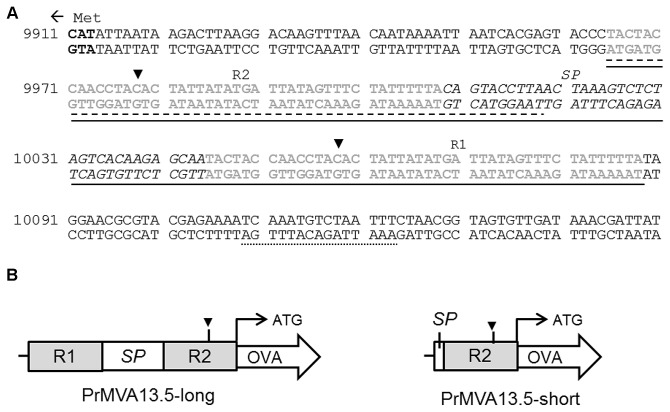
The MVA13.5L promoter.(A) The MVA sequence 250 nucleotides (nt) upstream of the MVA13.5L open reading frame (ORF) with a ‘left’ orientation is shown (GenBank accession number AY603355). The ATG encoding for the methionine (Met) within the MVA13.5L ORF is shown in bold. The arrow indicates the direction of transcription for the MVA13.5L gene. The two transcriptional start sites (TSS) for the MVA13.5L gene are indicated by black arrow heads. TSS1 correspond to nt 9 978 and TSS2 corresponds to nt 10 058 in the MVA genome. The two 44 nt repeats, denoted R1 and R2, are shown as grey sequences. The 36 nt spacer region between R1 and R2, denoted SP, is shown as sequences in italic. The sequences used to construct the PrMVA13.5-long promoter (9 965–10 088 nt) are underlined with a solid line. Sequences used to construct the PrMVA13.5-short promoter (9 965-10 019 nt) are underlined with a dashed line. (B) The features of the native PrMVA13.5-long and PrMVA13.5-short promoter are depicted graphically. The PrMVA13.5-long consists of the two repeated motifs (R1 and R2) shown as grey boxes separated by the spacer region (SP). The PrMVA13.5-short consists of only the R2 motif and 11 nt of the spacer region (SP). The TSS1 is shown as a black arrowhead. The promoters were used to generate an OVA expression cassette introduced into the MVA genome at IGR 44/45. The position of the promoter sequences relative to the start (ATG) of the OVA open reading frame (ORF) is shown. Arrows indicate the direction of transcription.